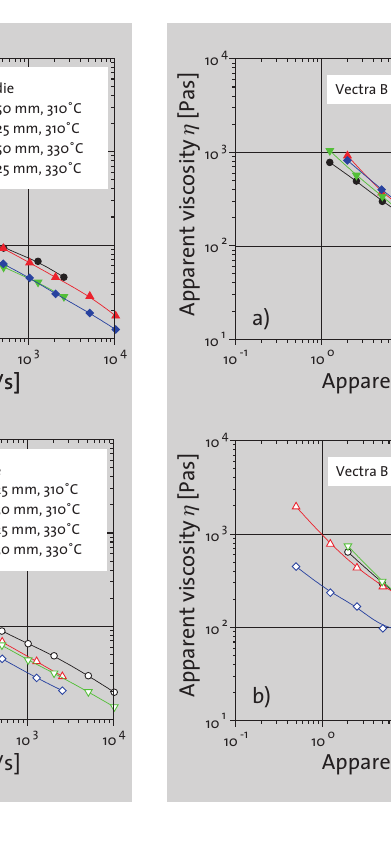
Figure 5 (left): Apparent viscosity of Vectra L 950 in the convergent and in the divergent double slit die at 310°C and 330°C. Figure 6 (right): Apparent viscosity of Vectra B 950 in the convergent and in the divergent double slit die at 300°C and